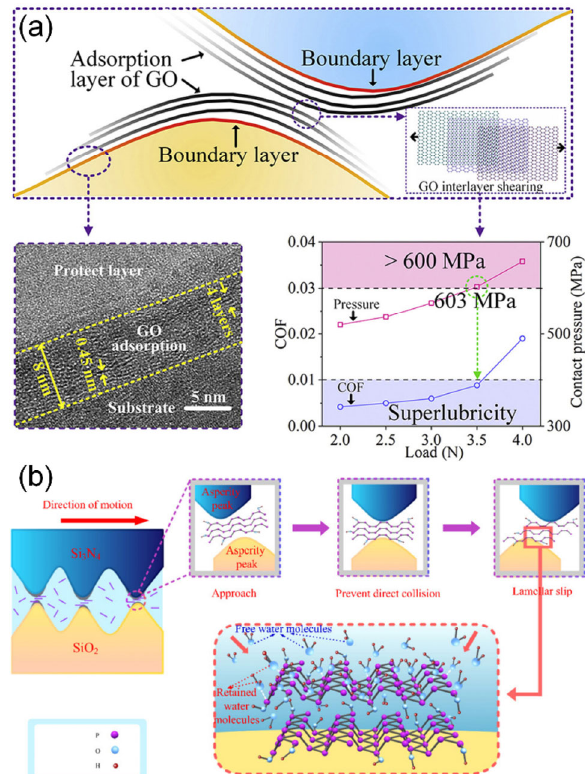
Fig. 6 (a) Superlubricity achieved under high pressure with a mixture of GO and [Li(EG)]PF 6 ; here GO provides protection for the surface, as well as low interlayer shear resistance. Reproduced with permission from Ref. [61]. © Elsevier Ltd., 2019. (b) Superlubricity realized by using BP as an additive. In this condition, the water layer captured by BP–OH is the main reason for friction